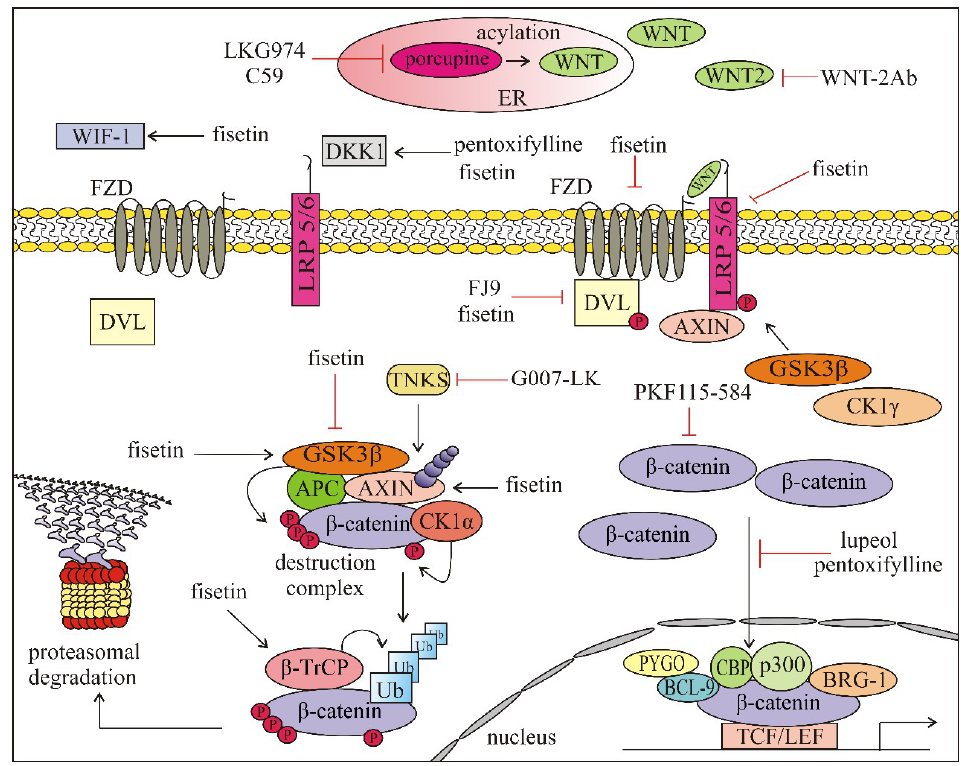
Figure 6. CompoundsandantibodiesaffectingWNT / β -catenin-signalingpathwaythatwereinvestigated in melanoma (preclinical studies, except for LGK974, which is tested in the clinical trial